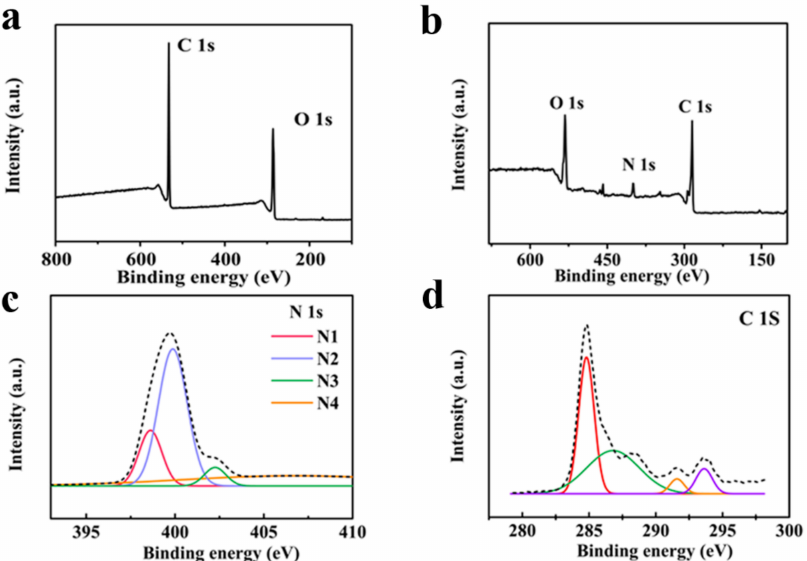
Figure 1. Characteristics of N-GNMs. ( a ) XPS spectrum of the N-GNMs; ( b ) XPS spectrum of the graphene oxide (GO); ( c ) High-resolution XPS spectrum showing the N 1s region of the N-GNMs; ( d ) High-resolution XPS spectrum showing the C 1s region of the